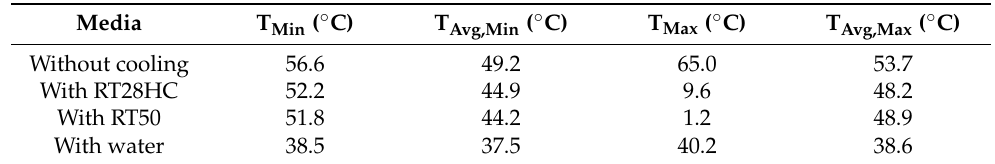
Table 4. Maximum, minimum, and average temperatures across the channels during the end of the experiment.